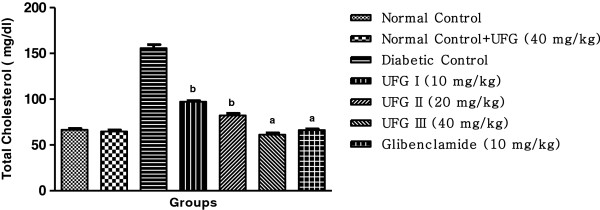
Effect of umbelliferone β-D-galactopyranoside on level of total cholesterol at different concentrations on STZ induced diabetic rats, compared to diabetic control group rats; values are mean ± SEM; n = 6;
c
P < 0.05;
b
P < 0.01;
a
P < 0.001; P > 0.05 is considered as non-significant (ns).